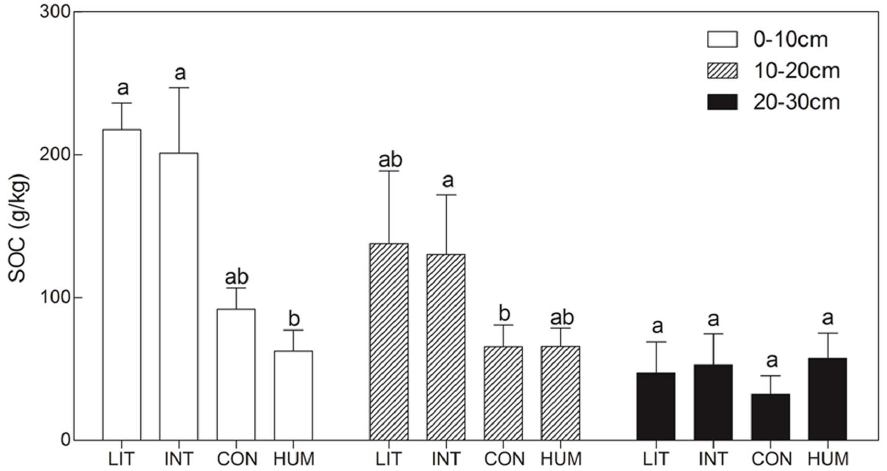
Fig. 3. SOC (mean ¡ SE) compared among the sites at three depth layers. Comparison of SOC in the 0– 10, 10–20 and 20–30 cm layers among the four sites. Within the same layer group, the SOC values with the same lowercase letter do not differ significantly ( P . 0.05) based on the Dunn’s multiple comparison test.